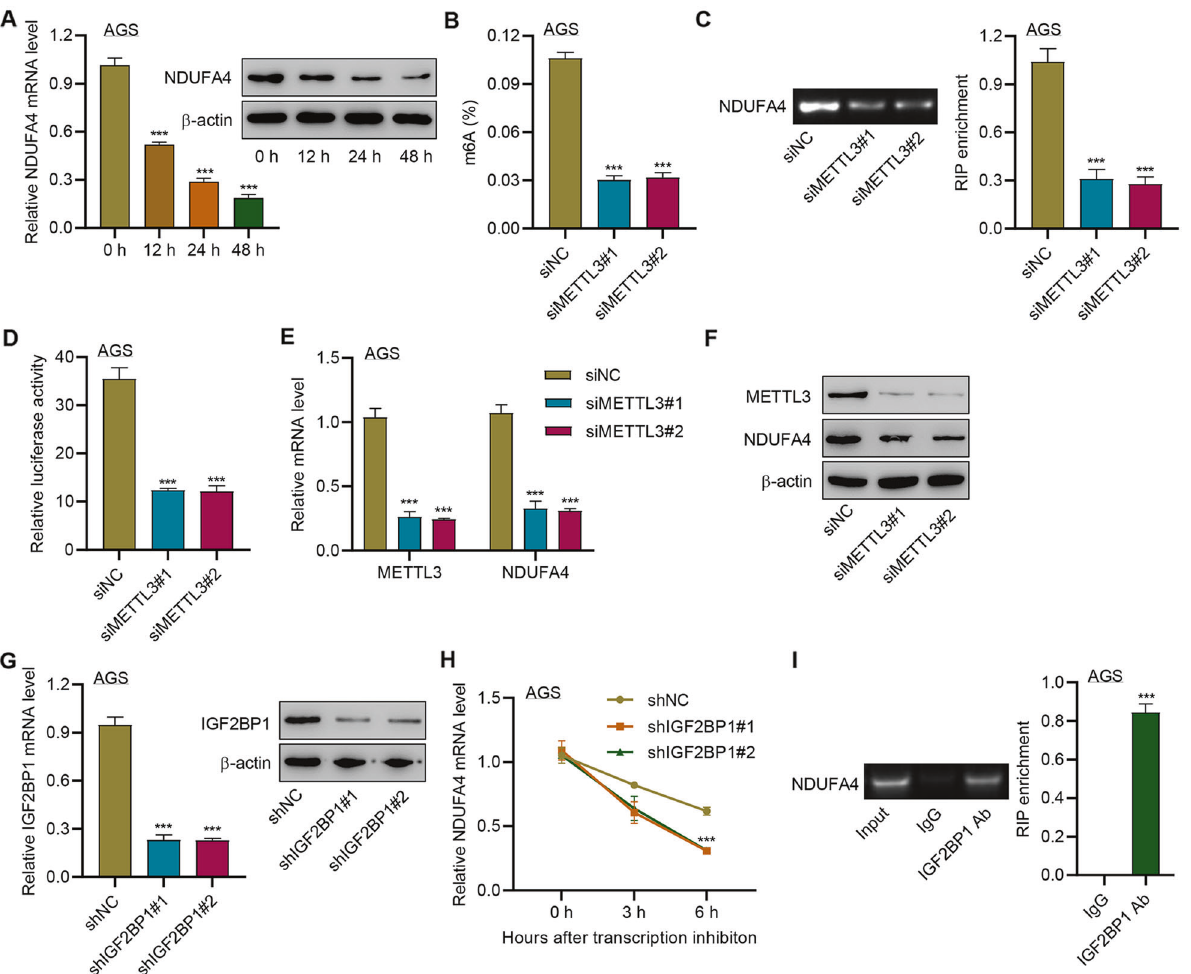
Fig. 8 METTL3 promoted the m6A modi fi cation of NDUFA4 via the m6A reader IGF2BP1. A NDUFA4 expression in AGS cells treated with 100 μ M 3-Deazaadenosine (DAA) for 0, 12, 24, and 48 h. B – F AGS cells were transfected with METTL14 siRNA. The whole m6A level ( B ), m6A level of NDUFA4 3 ’ UTR ( C ), and abundance of NDUFA4 3 ’ UTR ( D ) were detected. The expression of METTL3 ( E ) and NDUFA4 ( F ) was detected. G – H IGF2BP1 expression ( G ) and NDUFA4 mRNA stability ( H ) in AGS cells transfected with IGF2BP1 shRNA. I The interaction between IGF2BP1 and NDUFA4 3 ′ UTR was detected by RIP assay. *** P < 0.001 vs 0 h, siNC, shNC or